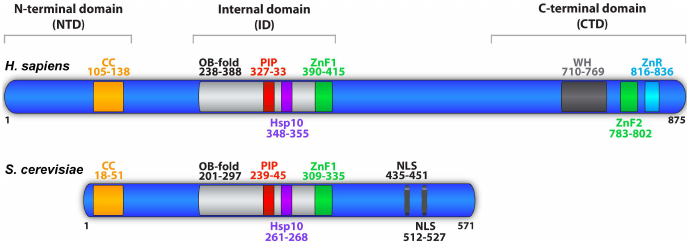
Figure 1. The domain structure of minichromosome maintenance protein 10 (Mcm10). Full-length Mcm10 is depicted for Homo sapiens (875 amino acids (aa)) and Saccharomyces cerevisiae (571 aa). Mcm10 functional domains and the amino acid regions they span depicted. The N-terminal domain (NTD) contains a coiled-coil (CC, orange) motif responsible for Mcm10 self-interaction. The internal domain (ID) mediates Mcm10 interactions with proliferating cell nuclear antigen (PCNA) and DNA polymerase-alpha (Pol-α) through a PCNA-interacting peptide (PIP) box (red) and Hsp10-like domain (purple), respectively. These motifs reside in the oligonucleotide/oligosaccharide binding (OB)-fold (light gray). The OB-fold along with zinc-finger motif 1 (ZnF1, green) serve as a DNA-binding domain. The C-terminal domain (CTD) is specific to metazoa and interacts with DNA primarily through ZnF2 (green). The CTD also includes the zinc ribbon (ZnR, blue) and winged helix motif (WH, dark gray); however their functions are currently unknown. A bipartite nuclear localization sequence (NLS) has been identified in S. cerevisiae .